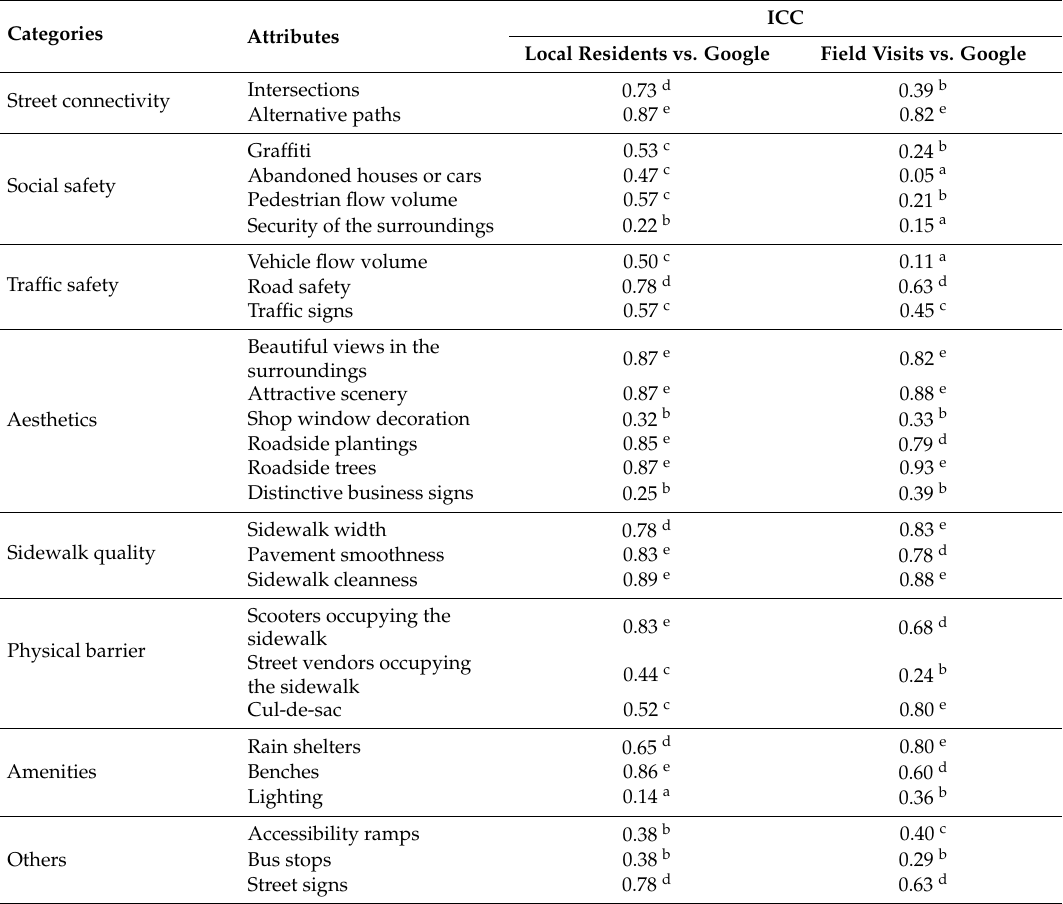
Table 4. ICC for the walkability